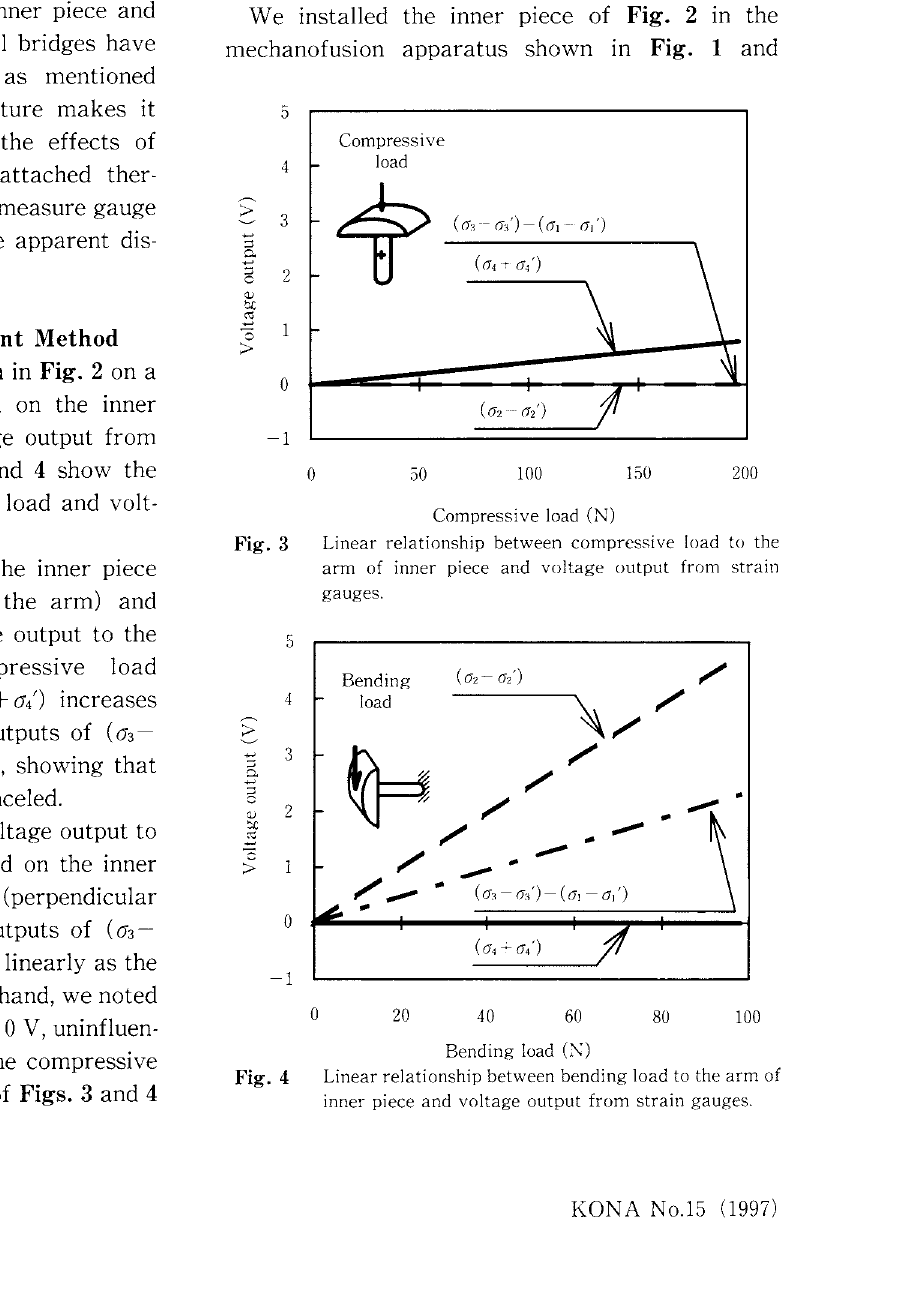
Linear relationship between compressive load to the arm of inner piece and voltage output from strain gauges.